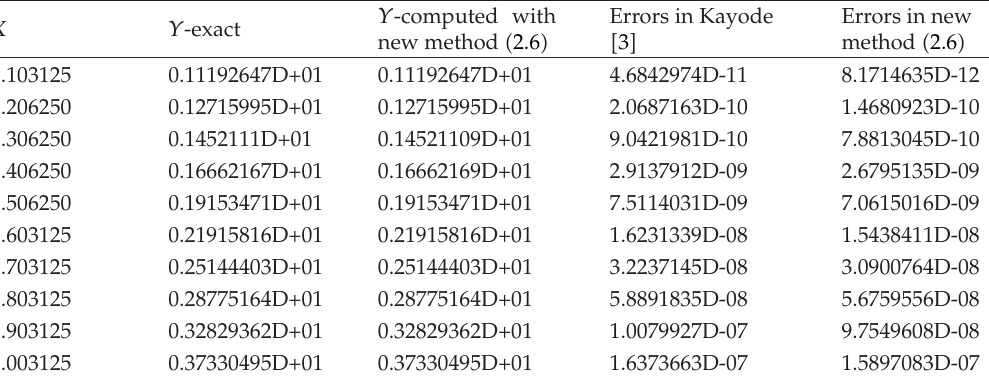
Table 2: Comparison of errors in Kayode (cid:7) 3 (cid:8) and new method (cid:3) 2.6 (cid:4) for Problem 2. X Y